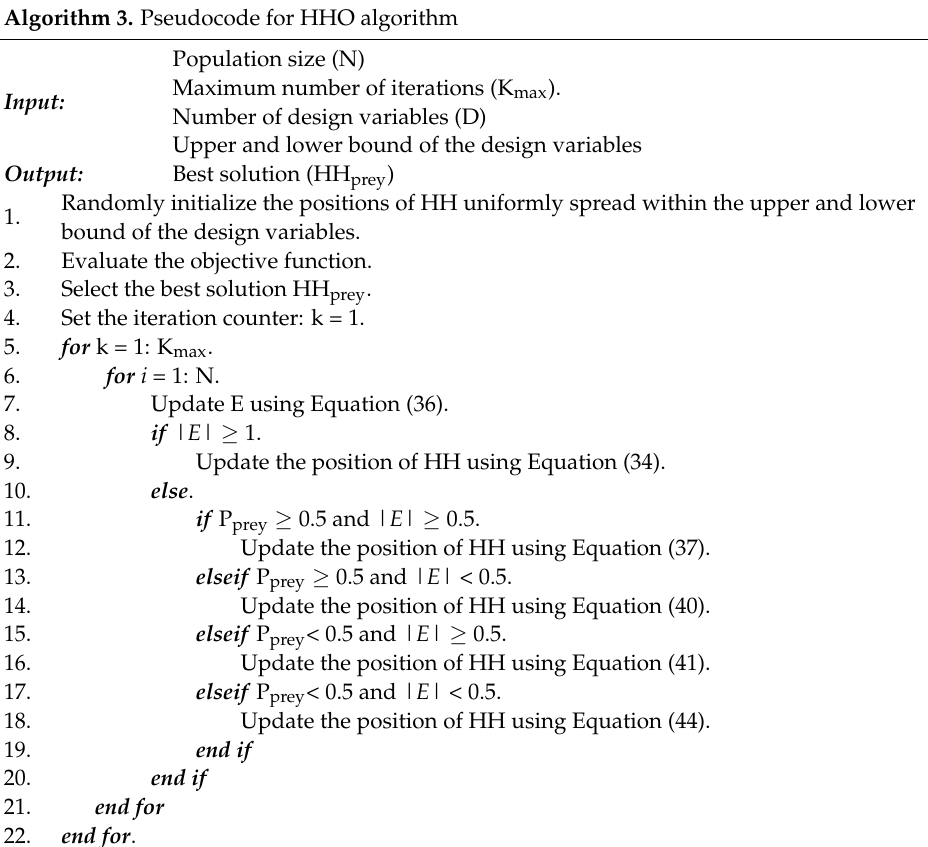
Algorithm 3. Pseudocode for HHO